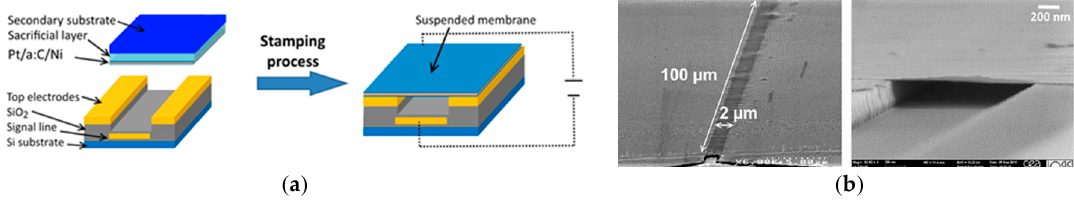
Figure 1. Realization of the devices ( a ) Scheme of the stamping process; ( b ) SEM pictures of membranes suspended above the